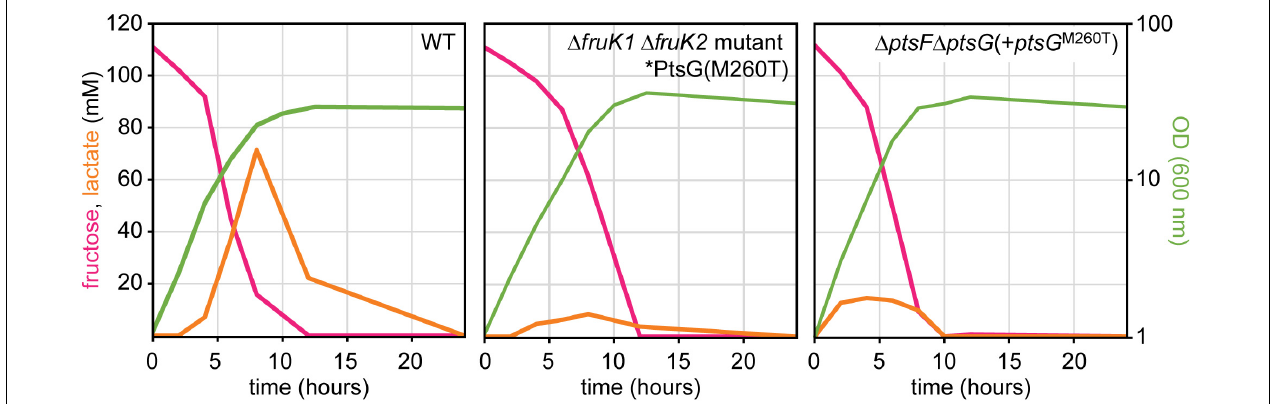
FIGURE 7 | Transient lactate accumulation in cultures of WT, mutant, and reconstructed strain during growth on fructose. Data represent one of two individual cultivations that differed < 5%.